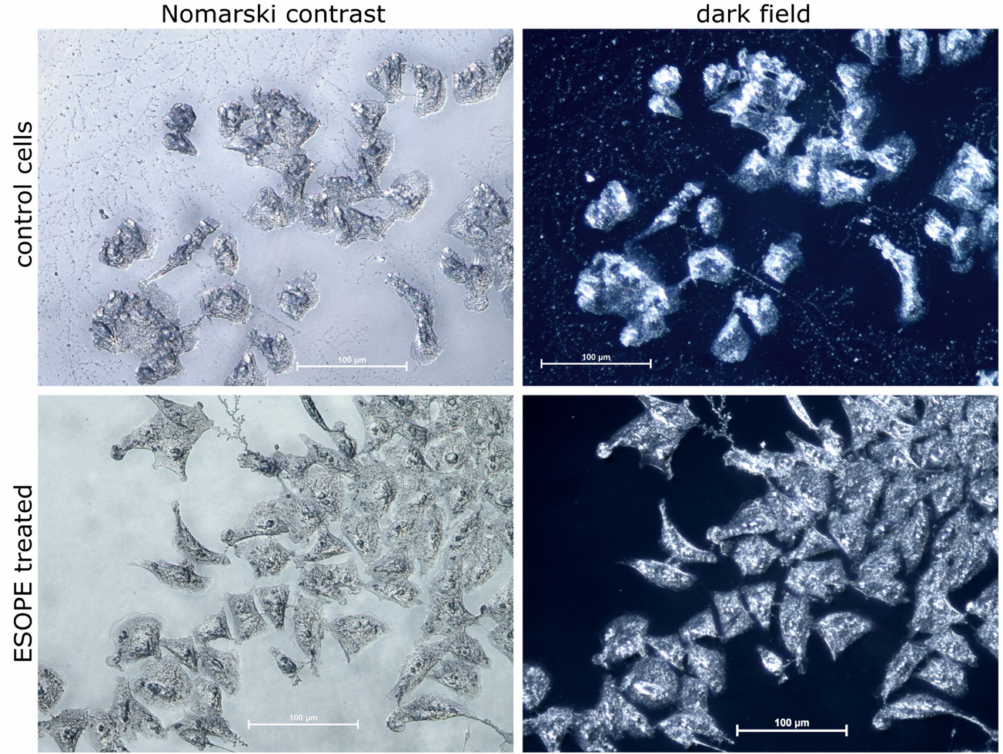
Figure 9. Visualization of morphology by Nomarski interference contrast microscopy of control MCF-7 / DOX cells and after application of electrical pulses (ESOPE parameters) within 24 h of incubation. The following changes in shape and inner structure of mitochondria were observed: smaller rounded mitochondria with densely packed cristae and bigger mitochondria with marginal cristae with a granular and homogenous inner compartment. After electropermeabilization alone (Figure 10c), an abundance of abnormal vacuoles with fibrous, heterogeneous and flocculent material were detected. Some large vesicles were situated at the periphery of the cells, containing only membranes, which suggests that their digested content had been eliminated during fixation. When an electric field was applied simultaneously with DOX (Figure 10d) the diversification in shape and inner structure of mitochondria was observed: an elongated shape and position closer to the cell membrane. Most cells contained vesicles corresponding to small roughly spherical primary lysosomes with homogenous dark content, and much larger and more irregularly shaped secondary lysosomes with heterogeneous content. Some vesicles of similar diameter contained clusters of numerous small vesicles, often enveloped in a membrane, so forming a multivesicular bodies in addition to heterogeneous material characteristic to secondary lysosomes. These compartments were surrounded by a double membrane suggesting that multivesicular bodies might engulfed in a large vesicle that had already fused with primary